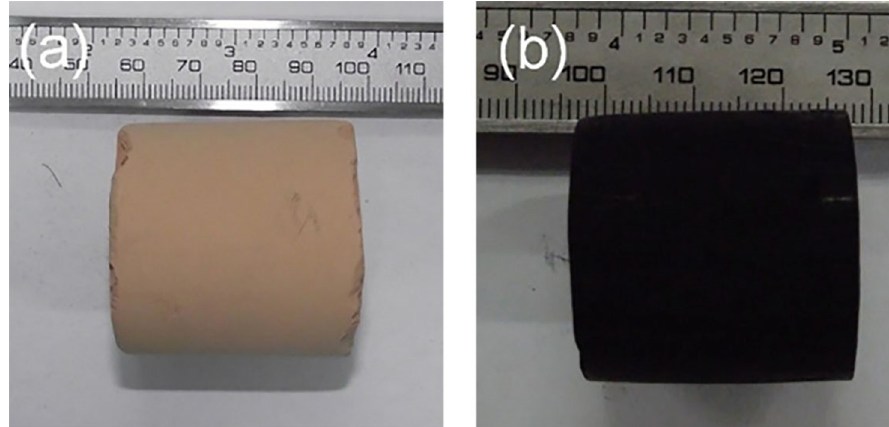
Figure 1: Sample of C/SiO 2 composite aerogel before ( a ) and after ( b ) heat